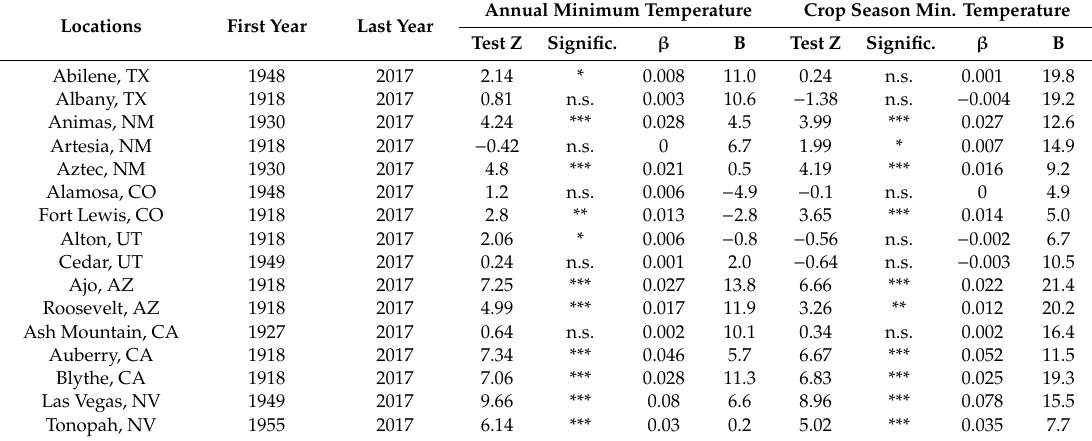
Table 4. Summary of the Mann–Kendall trend test for annual and crop season minimum